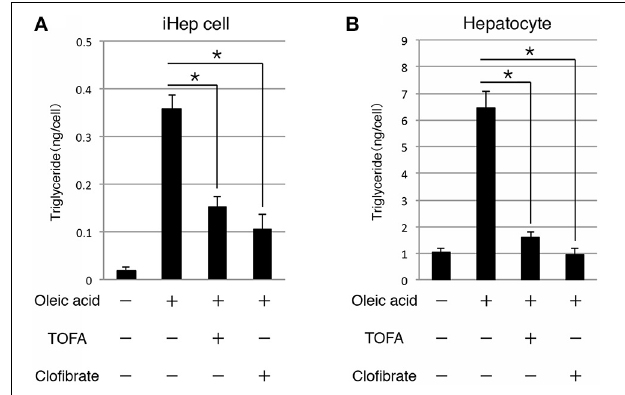
FIGURE 4 | iHep cells can respond to lipid metabolism improvers. (A,B) Quantification of triglyceride contents in iHep cells (A) and primary hepatocytes (B) cultured with or without oleic acid, and supplemented with or without the well-known lipid metabolism improvers TOFA or clofibrate. The graphs show the average of three independent experiments (mean ± SD). ∗ P < 0 . 01 (One-Way ANOVA).